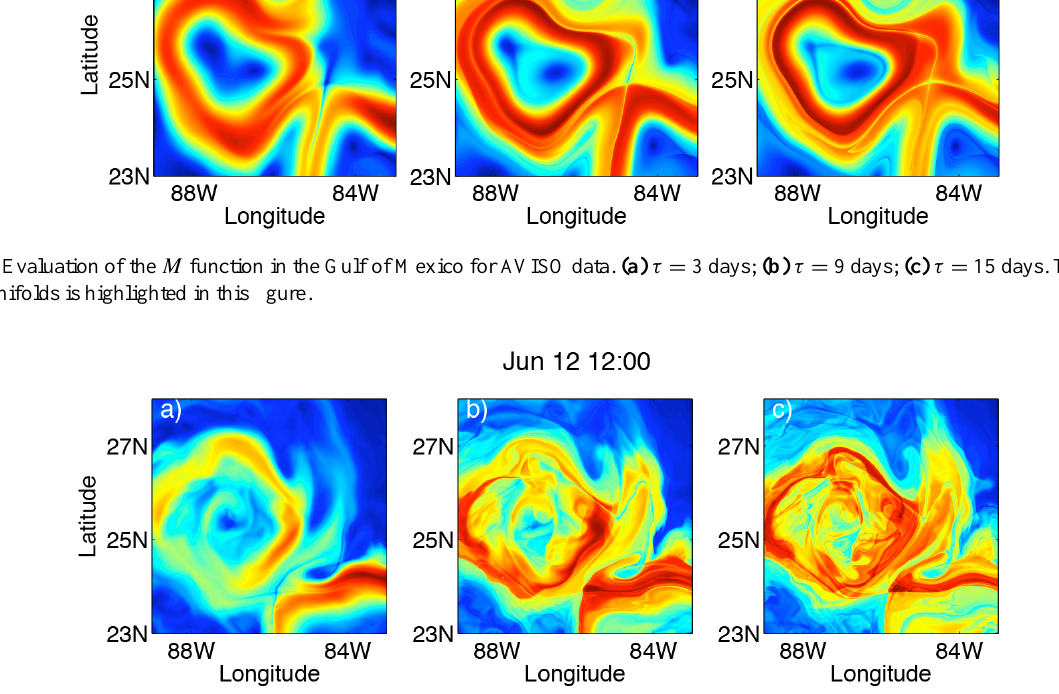
Figure 2. Evaluation of the M function in the Gulf of Mexico for HYCOM data. (a) τ = 3 days; (b) τ = 9 days; (c) τ = 15